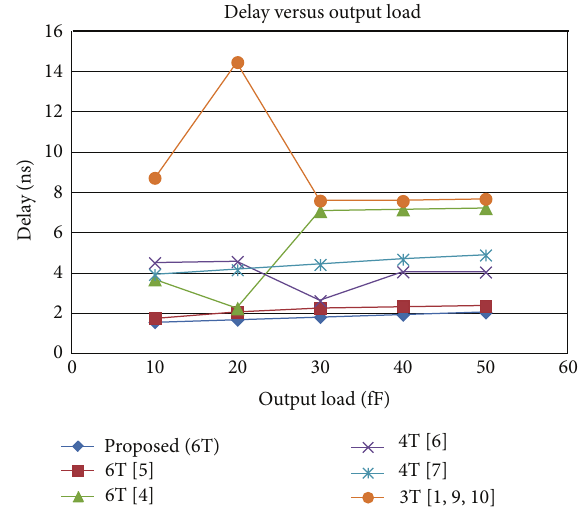
Figure 6: Line graph showing the comparison of the propagation delay versus output load for various CMOS XOR gates with the proposed novel CMOS pass-transistor-based full-swing XOR